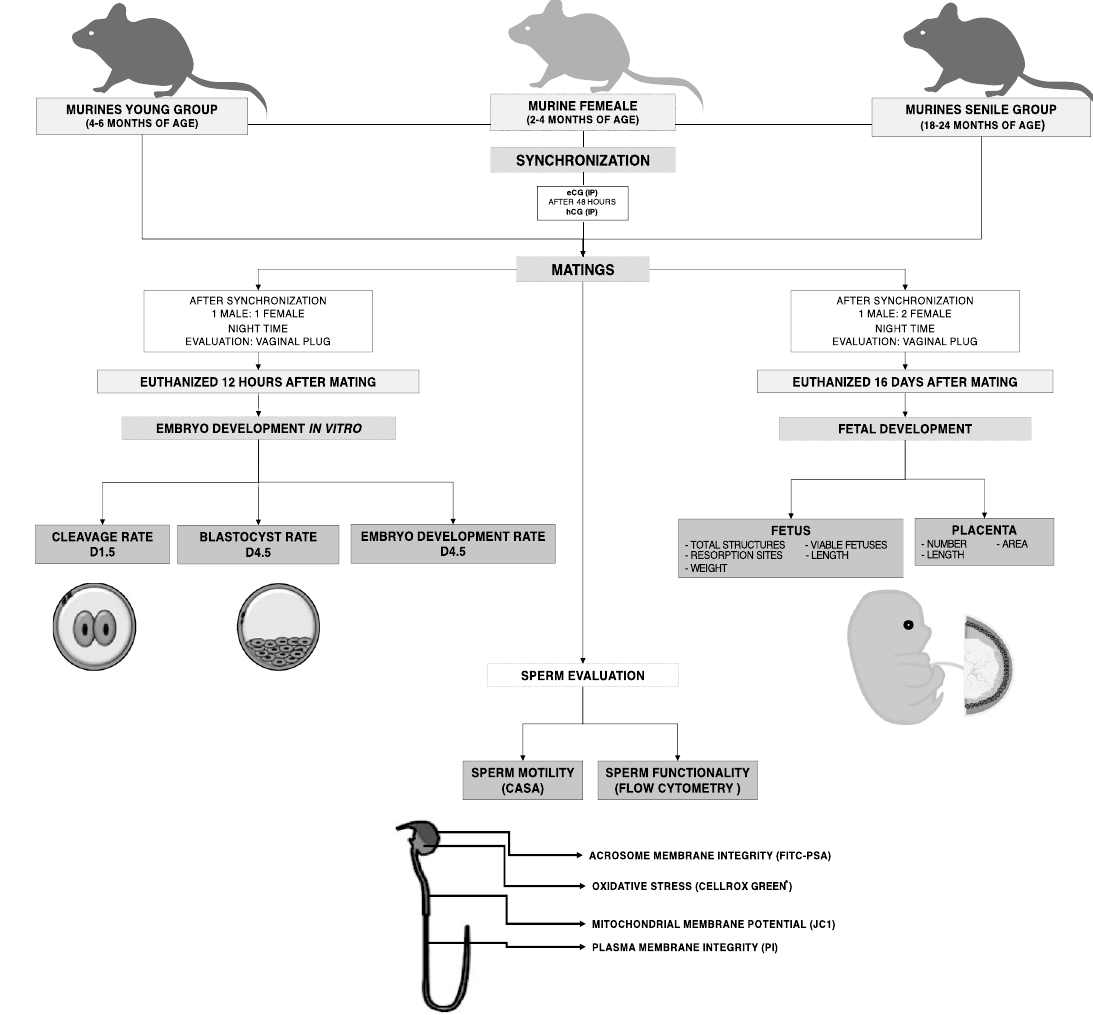
Figure 4. Experimental design. Male murines divides into two groups, senile (18–24 months of age) and young (4–6 months of age), who mated with a group of murine females synchronized, for the realization of three experiments: embryo development in vitro, fetal development, and sperm